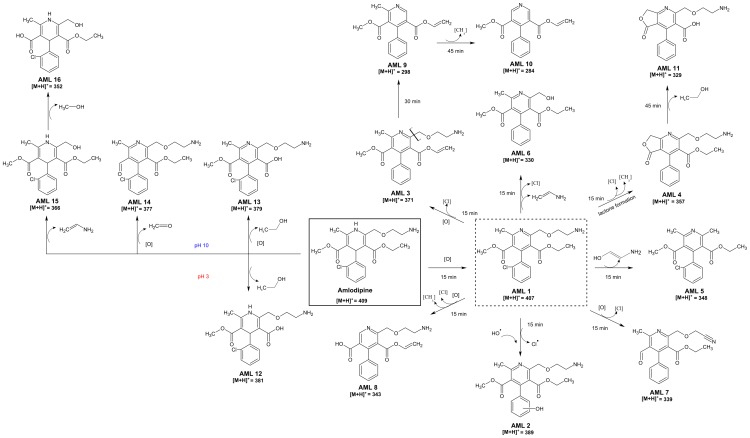
Proposed photodegradation pathway of amlodipine.